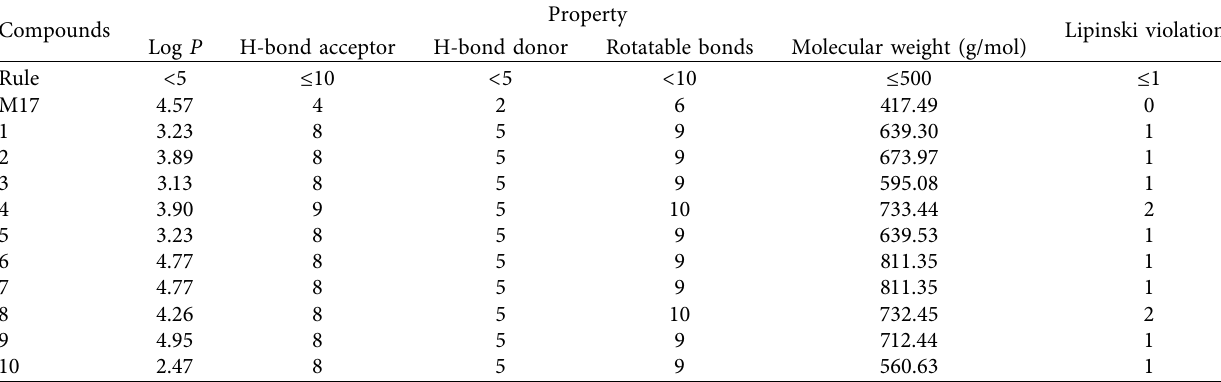
Table 8: Lipinski’s rule of newly designed inhibitors and the most potent inhibitor in the dataset.